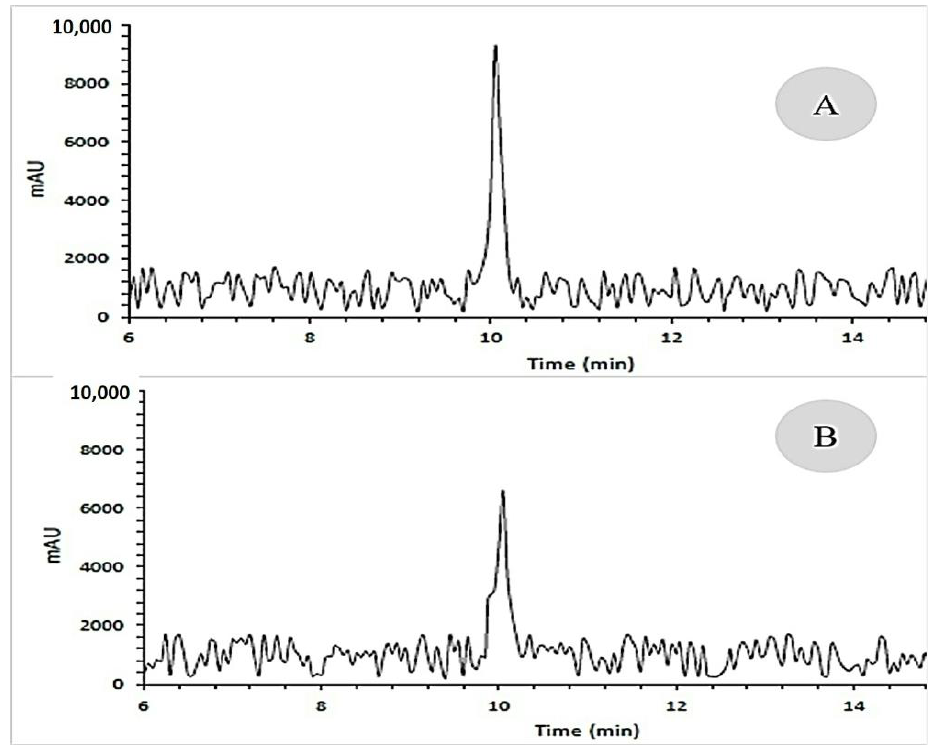
Figure 1. HPLC representative chromatogram of galactitol (retention time: 10.05 min): ( A ) standard extracts and ( B ) seed extracts of Cuscuta campestris developed on various hosts.